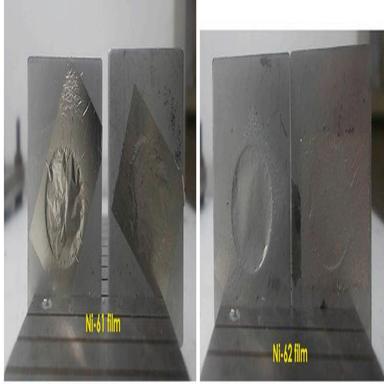
The target holder containing 61Ni target (left) and 62Ni target (right).